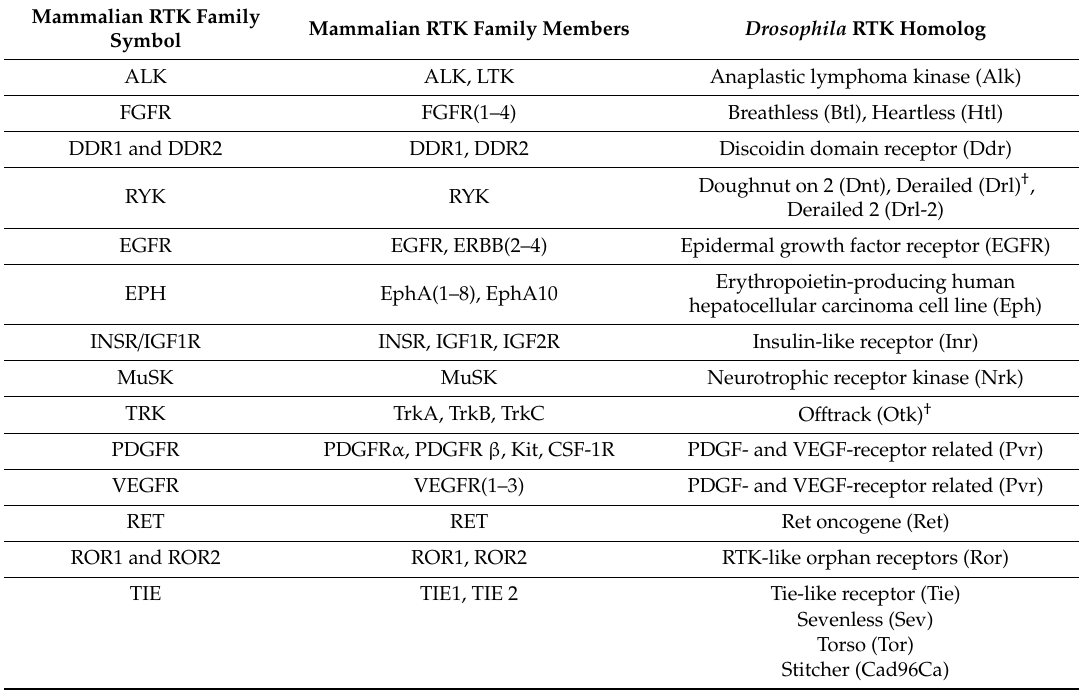
Table 1. Drosophila RTKs and their respective mammalian